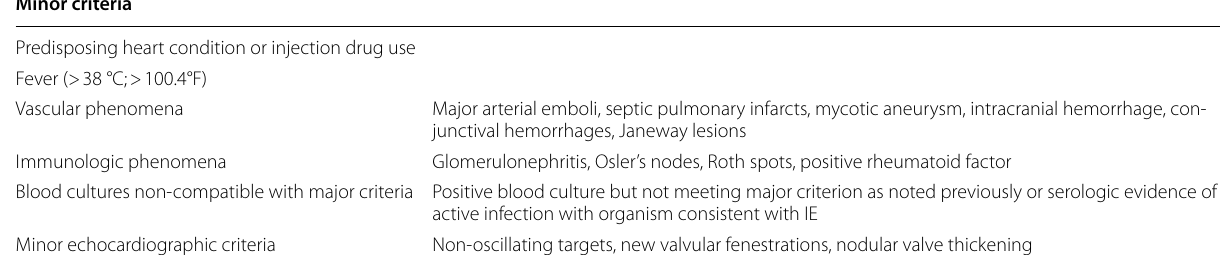
IE infective endocarditis; HACEK Haemophilus species, Aggregatibacter species, Cardiobacterium hominis, Eikenella corrodens, and Kingella species ; The diagnosis of infective endocarditis (clinical definition) is definite when 2 major criteria, or 1 major criterion and 3 minor criteria, or 5 minor criteria are meet; IE possible when neither non-definite nor rejected-criteria are meet; IE rejected when a firm alternate diagnosis of endocarditis is meet, or resolution of symptoms is achieved with antibiotic therapy for 4 days or less [2,